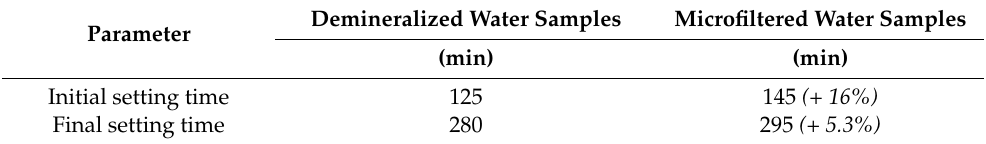
Table 6. Cement paste sample setting